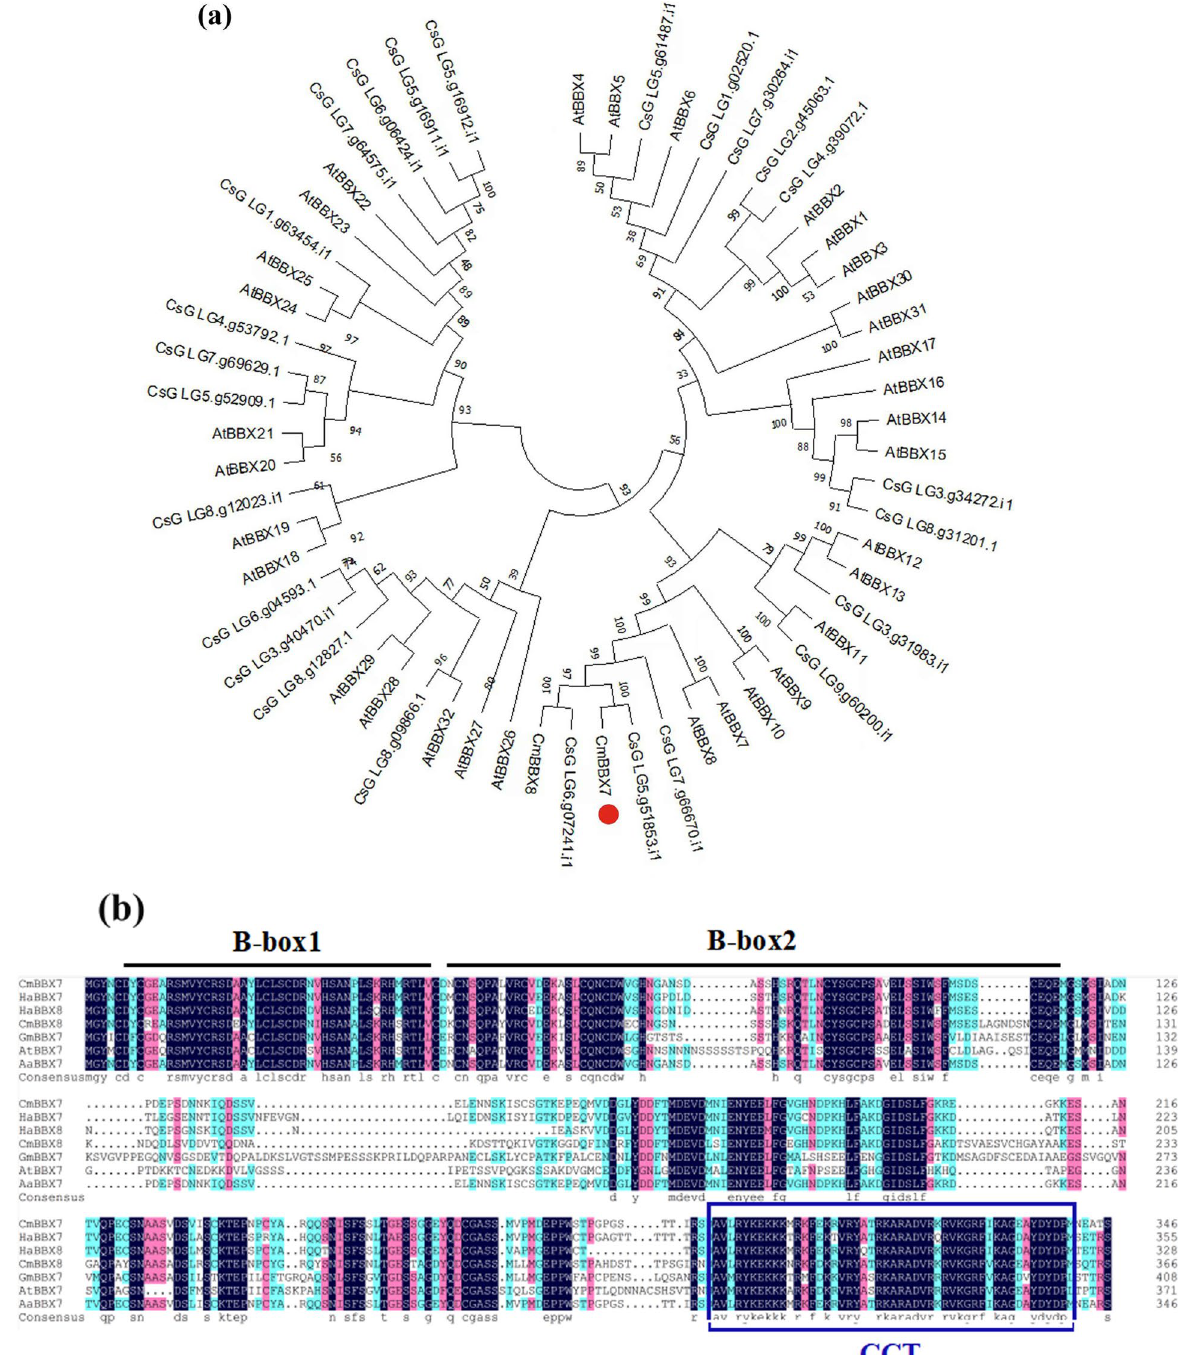
Fig. 1 CmBBX7 encodes a BBX family subgroup II protein. a Phylogenetic relationships of CmBBX7 and BBX sequences from Arabidopsis and Chrysanthemum seticuspe . Protein sequences of the 32 BBXs in Arabidopsis were obtained from The Arabidopsis Information Resource (TAIR) database, the sequence of BBX8 in chrysanthemum was obtained from the National Center for Biotechnology Information (NCBI), and the genome sequence and annotation data of C. seticuspe are available at PlantGarden with Project ID PRJDB7468. The percentage of trees in which the associated taxa clustered together is shown next to the branches. b Alignment of the deduced polypeptide sequences of CmBBX7 with those of other plant BBXs. The B-box1 and B-box2 domains are indicated by the black lines above the sequences. The CCT motif is indicated by the blue lines around the